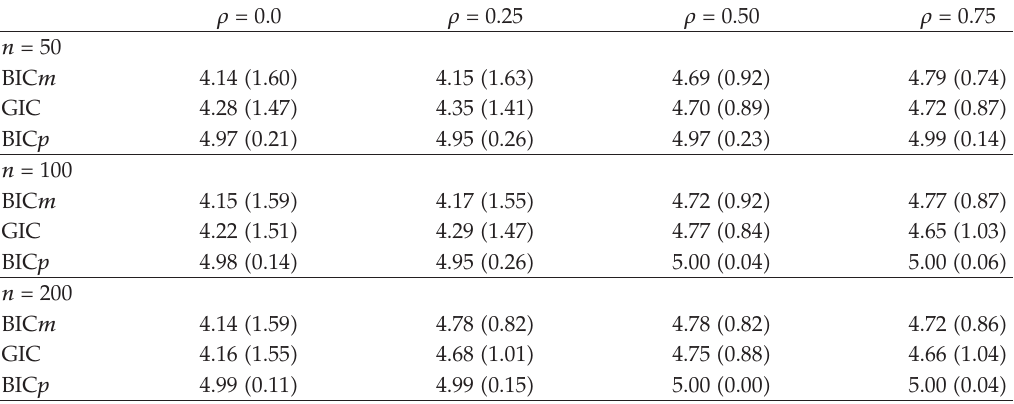
Table 8: Means (cid:3) standard deviations (cid:6) of the number of explanatory variables excluded. ρ (cid:7) 0 .